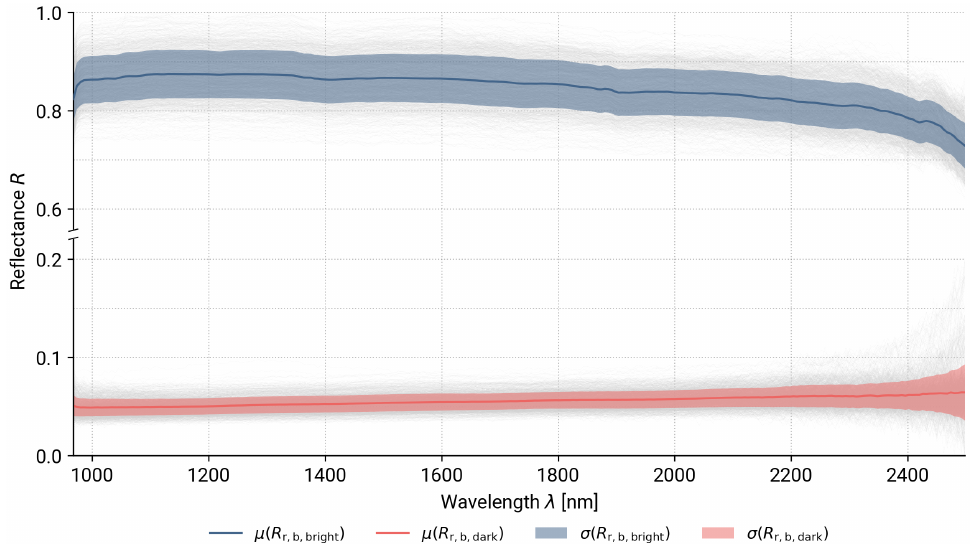
Figure A1. Reflectance spectra of the bright (1047 spectra) and the dark background (1041 spectra) and their mean and standard deviations. The axis scaling of R differed among the